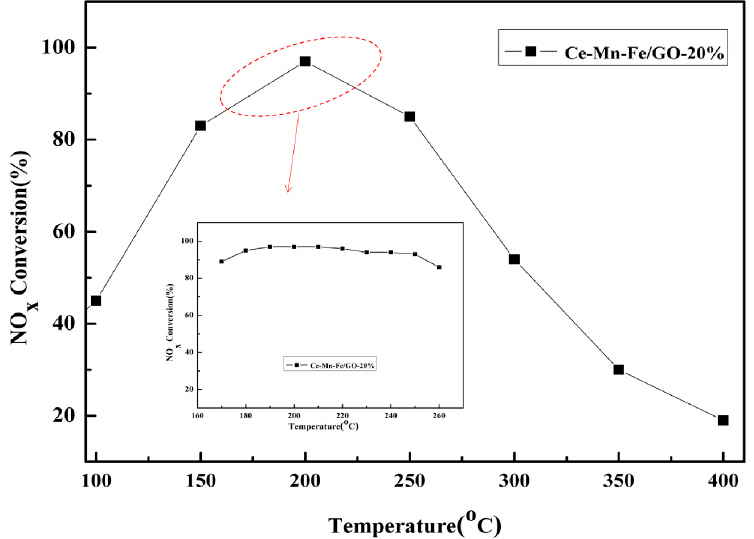
Figure 6. NO x conversion as a function of reaction temperature over the Ce-Mn-Fe/GO-20% sample. (Flue gas conditions: 6% O 2 , 600 ppm SO 2 , 800 ppm NO, 800 ppm NH 3 , N 2 as balance gas). The N 2 O output concentration over Ce-Mn-Fe/GO-20% is shown in Figure 7a. This shows that